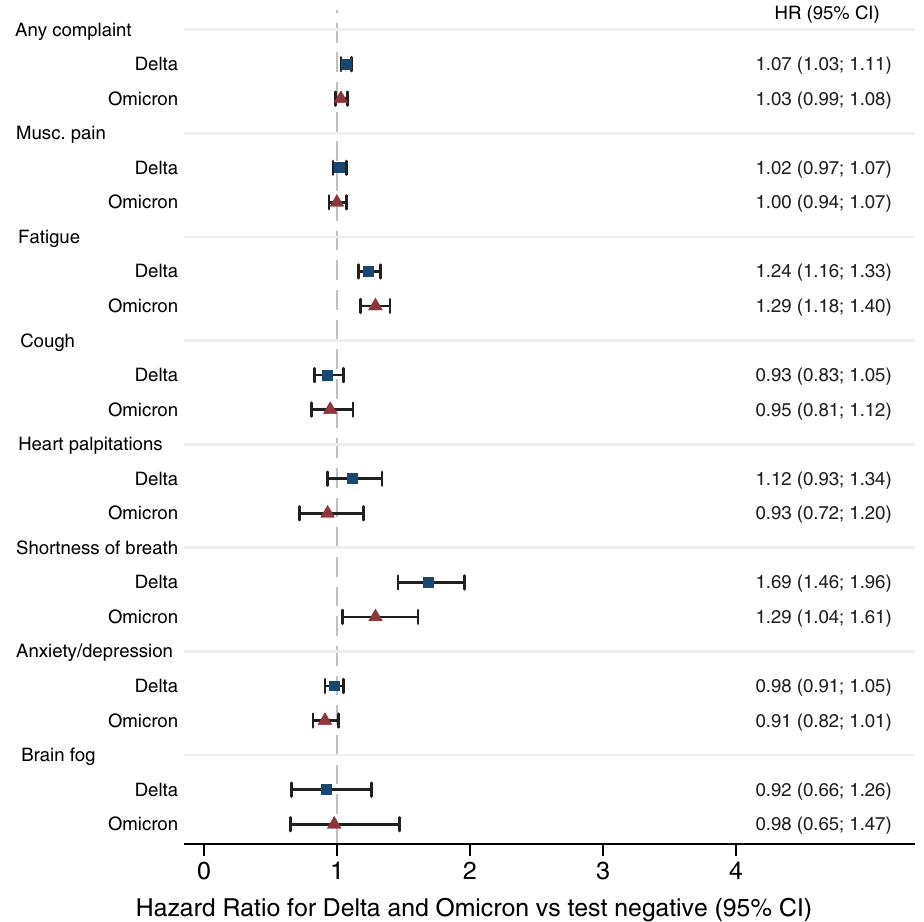
con fi dence interval (CI) and examined over 8 independent experiments, one for each post-covid outcomes. Blue squares represent the estimates for the Delta variant compared to individuals testing negative. Red triangles represent the esti- mates for the Omicron variant compared to individuals testing negative. Musc. pain=musculoskeletal pain. Source data are provided as a Source Data fi